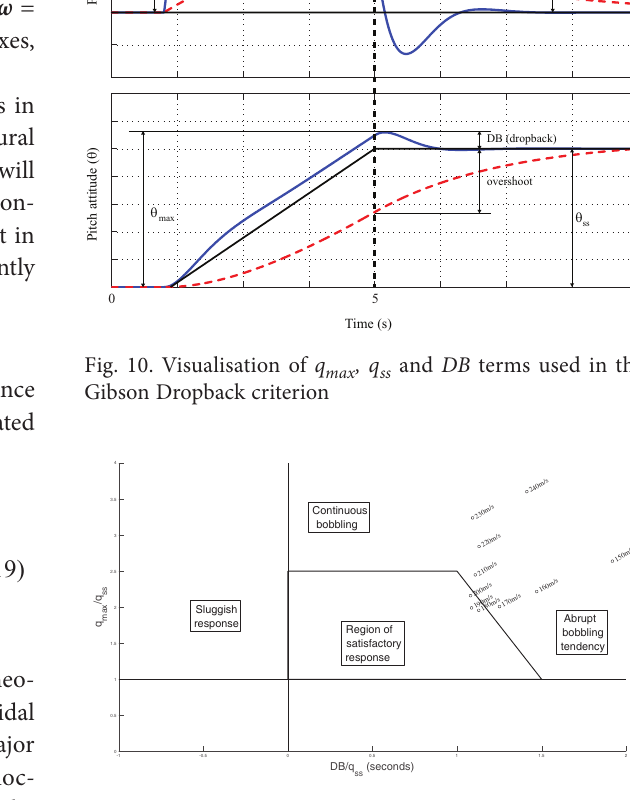
Fig. 11. Effect of airspeed on the longitudinal handling qualities of the AX-1